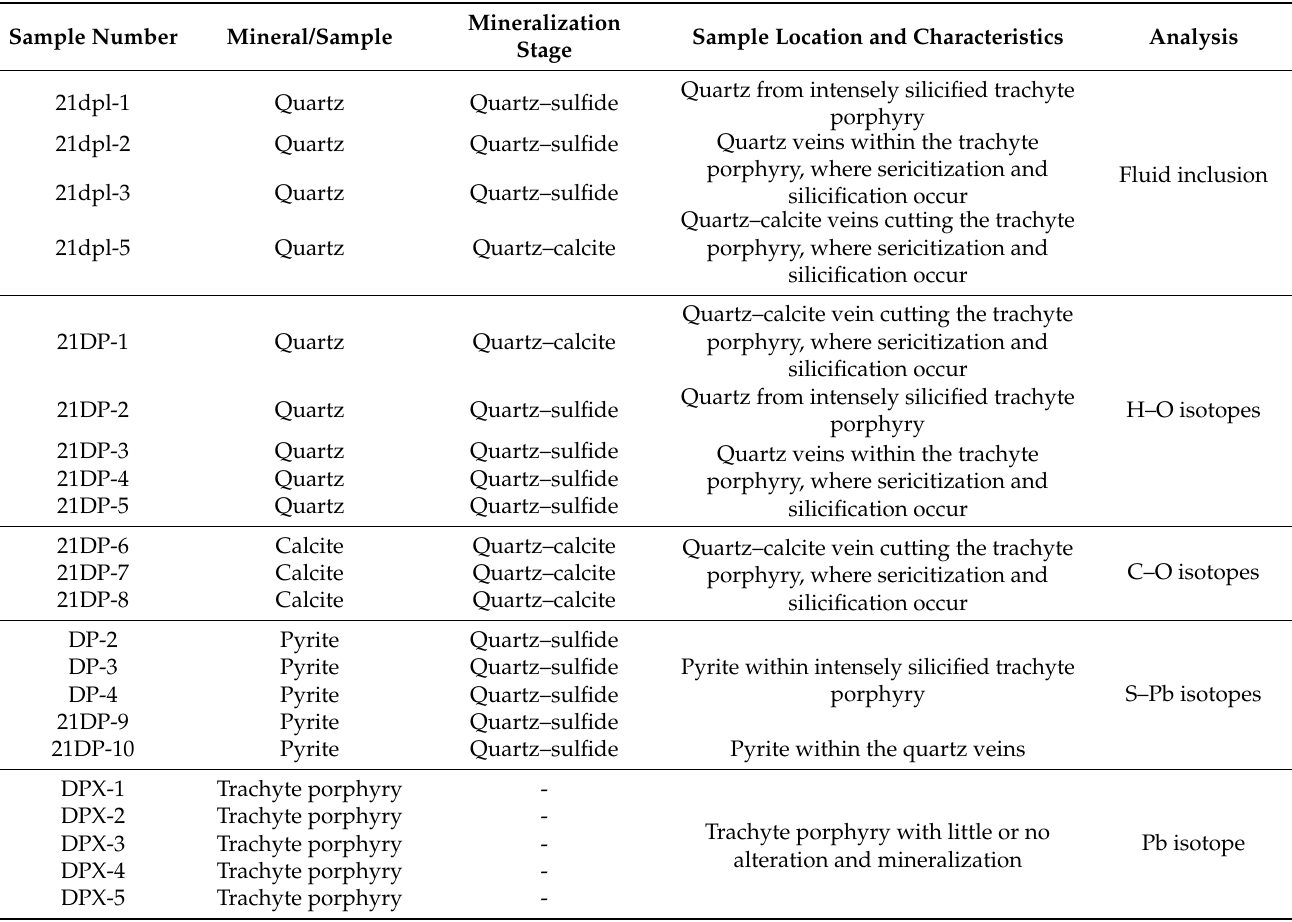
Table 1. Sample characteristics of the Dongpuzi gold